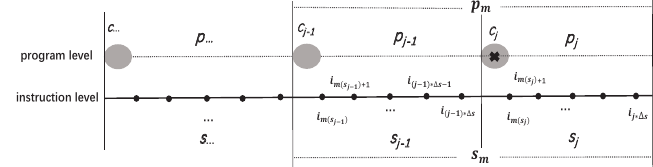
Figure 11. An example of deleting a